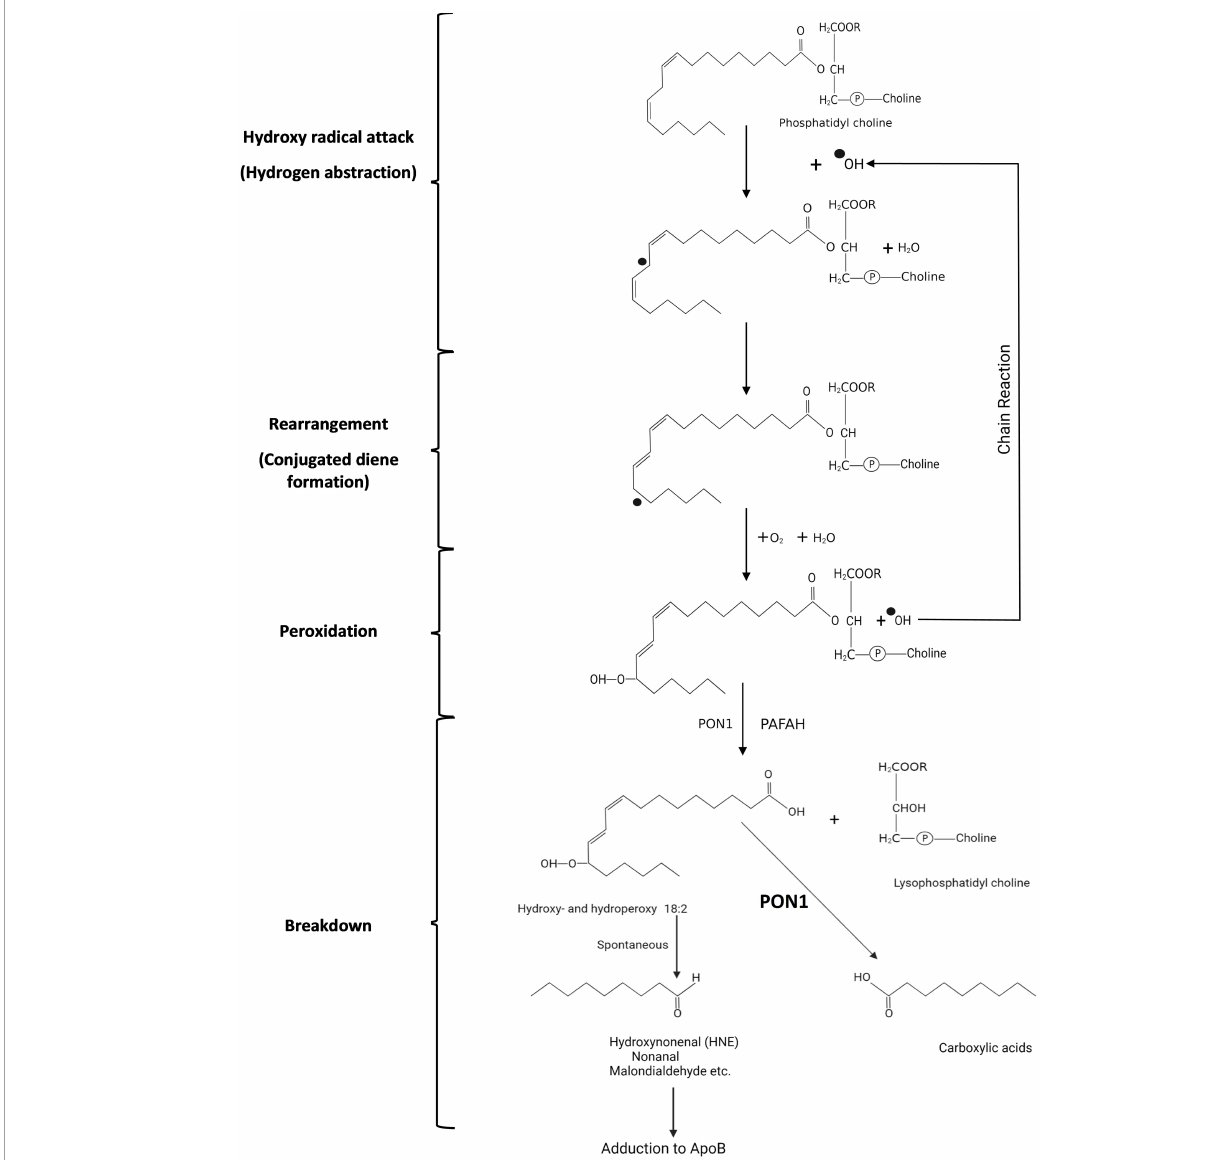
FIGURE3 Symbolic representation of the peroxidation of phosphatidyl choline with linoleate in Sn2 by reactive oxygen species (hydroperoxy radical in this example). A superscript dot preceding an atom indicates an unpaired electron. (1) Hydrogen abstraction from the hydrocarbon chain leads to (2) rearrangement in which the double bonds between carbon 6 and 9 are no longer separated by 2 single bonds but by only one (conjugated diene formation). (3) Addition of oxygen then leads to peroxy radical formation with the potential for initiating a chain reaction and (4) spontaneous breakdown to aldehydes and ketones which can adduct to apolipoprotein B of LDL altering its receptor-binding. When PON1 in HDL is present breakdown to carboxylic acids rather than aldehydes and ketones is believed to